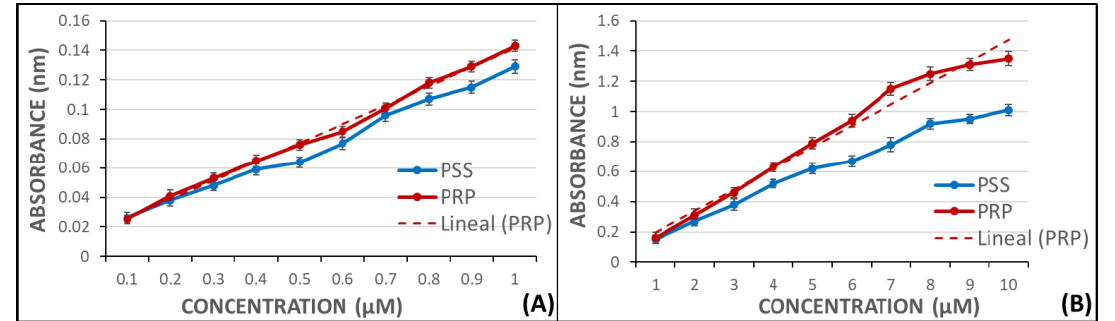
Figure 6. Calibration absorbance curves of MDA in PSS and PRP. ( A ) Range from 0.1 to 1 µM and linear fitting in PRP samples ( r = 0.997). ( B ) Range from 1 to 10 µM and linear fitting in PRP samples ( r = 0.994).